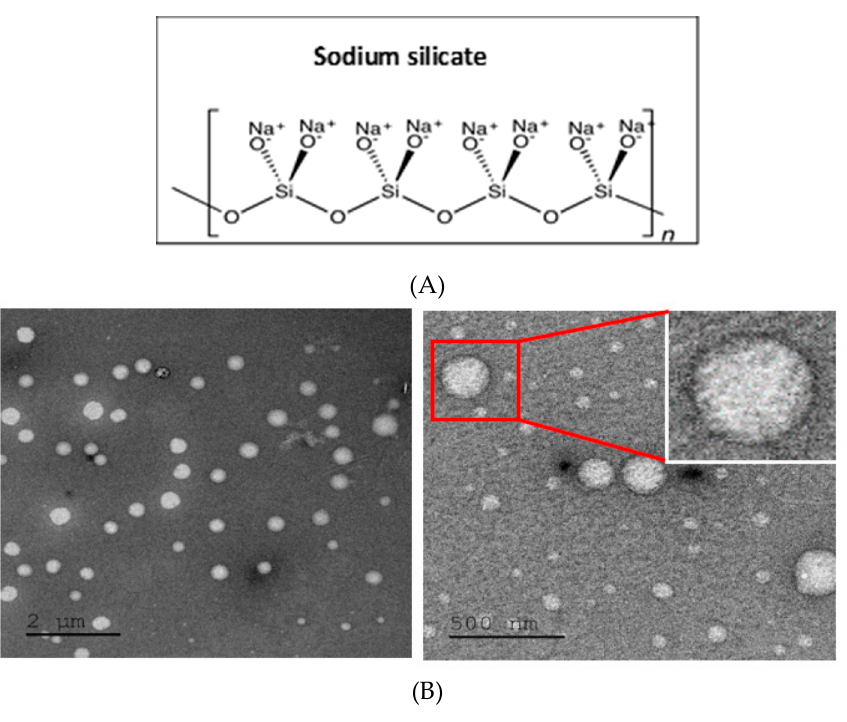
Figure 3. Effect of sodium silicate on particle size and shape. ( A ) Chemical structure of sodium silicate. ( B ) TEM images of particles fabricated with sodium silicate and CMC showing nanospheres with a size range of 30 to 50 nm together with some larger particles ~200–250 nm.